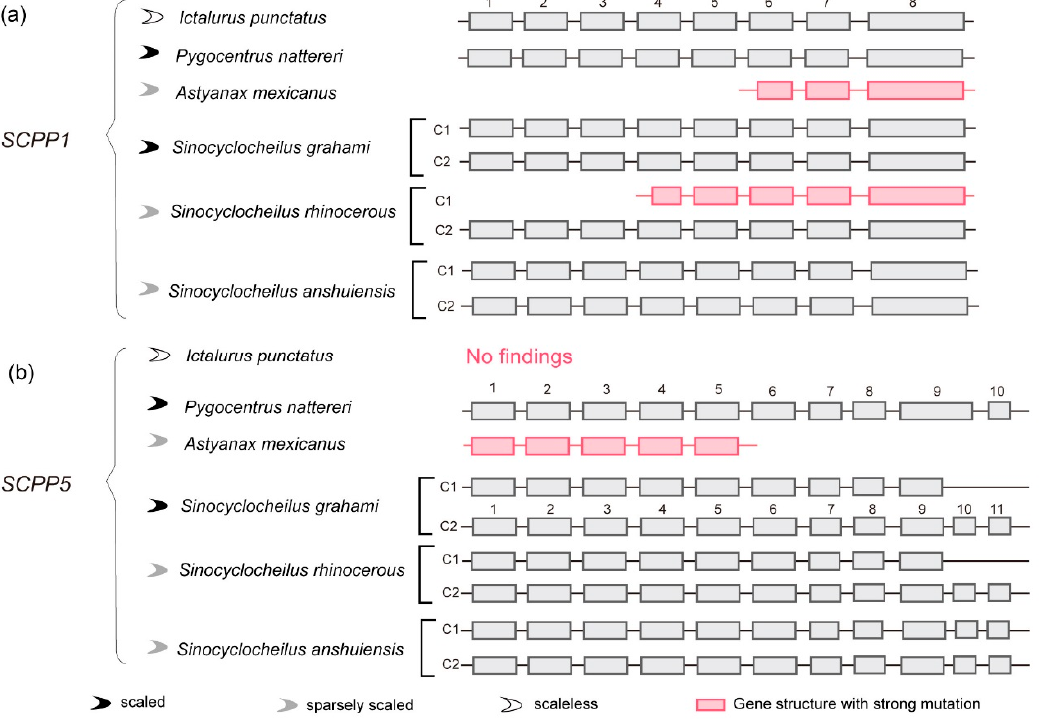
Figure 4. Comparison of candidate genes for determining scale phenotype among scaled, sparsely scaled, and scaleless fishes. ( a , b ) Structural alignments of SCPP1 and SCPP5 genes, respectively, in six representative fishes, namely, scaled PN and SG, sparsely scaled AM, SR, and SA, and scaleless IP.